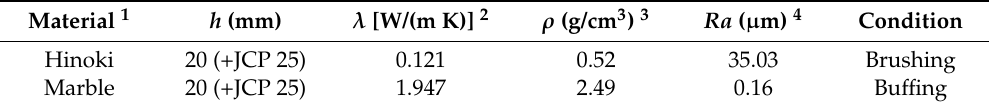
Table 1. The characteristics of the